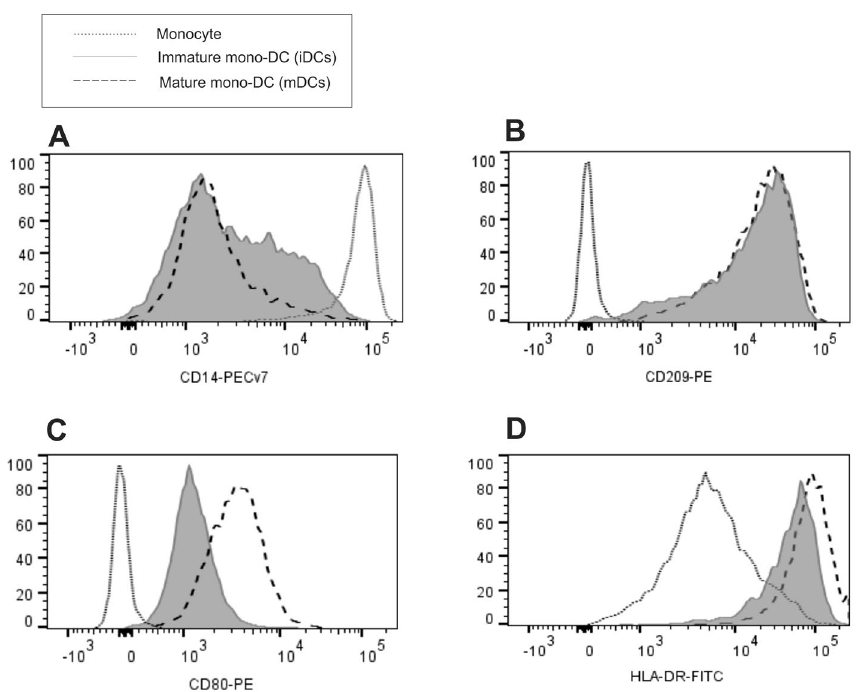
Figure 4. Flow cytometric analysis of monocytes differention into dendritic cells. The differentiation from monocytes was confirmed based on the comparison of CD14, CD209, CD80 and HLA-DR expression between monocytes, iDCs and mDCs, analysis of overlaid histogram by flow cytometry as follows: ( A ) there is decreasing expression of CD14 according to DC status of differentiation and maturation, and increasing expression of ( B ) CD209; ( C ) CD80 and ( D ) HLA-DR. Representative results of n = 8